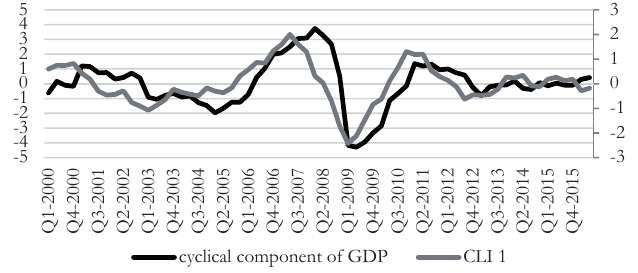
Fig. 2 – Development of the cyclical component of GDP and CLI 1, period 2000 – 2016. Source: own